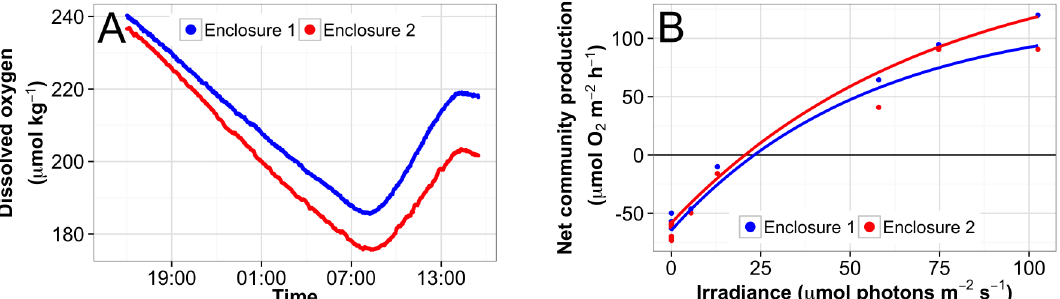
Figure 3. Measurements of the community metabolism of a Posidonia seagrass bed in the northwestern Mediterranean Sea performed in the frame of the eFOCE project. Oxygen variations (A) and photosynthesis–irradiance curves (B) during incubations performed in closed- chamber